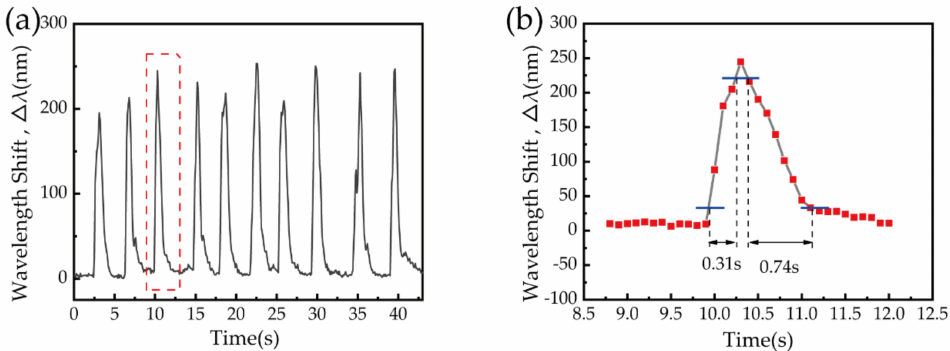
Figure 8. ( a ) Resonant wavelength shifts for the 2% (wt/wt) PVA sensor under several breaths. ( b ) The enlarged drawing of a single breathing process surrounded by the red frame in ( a ).